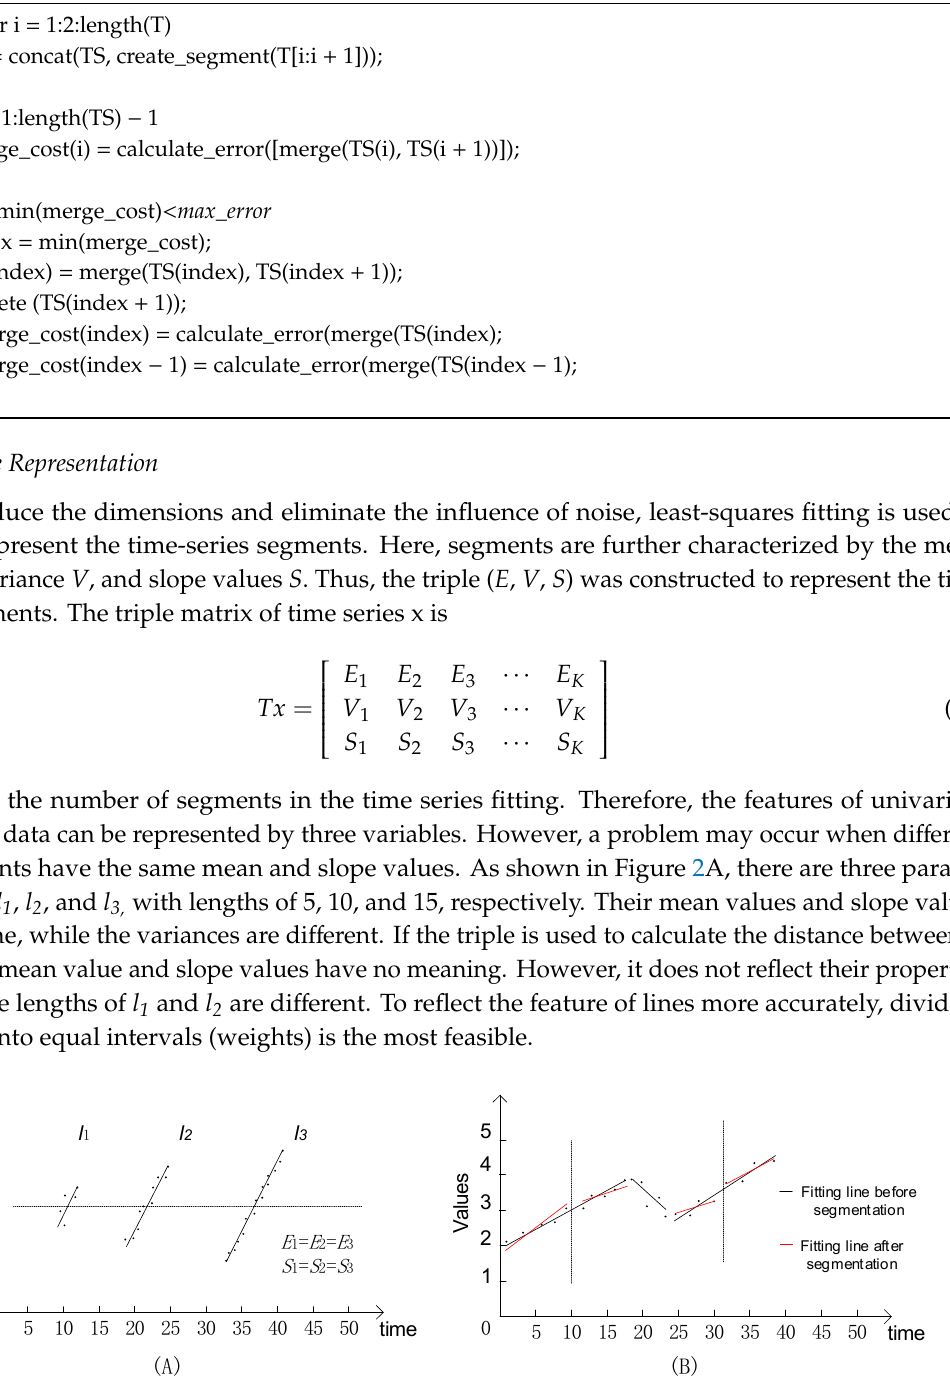
Figure 3. The fitting line of the data after segmenting with d = 5, max_error = 0.1. It cannot be guaranteed that each of the segments is the same after segmentation. For instance, the length of the third segment after segmentation is 4 in Figure 1B. However, the homogeneity of the segments can be guaranteed. In addition, the time series is represented as a matrix of triples after equal interval segmentation. 3.3. Metric Learning DTW is often used to calculate the univariable time series distance. In [28], DTW was extended to a multivariable time series, and the Euclidean distance was used for the local distance. The Euclidean distance considers each variable without considering the relationship between variables and is affected by noise and irregularity. In [19], DTW based on the Mahalanobis distance was used to calculate the multivariable distance for the first time. The Mahalanobis distance assigns different weights for different variables, and the relationships between variables are considered. 3.3.1. Calculate Multivariate Local Distance As described above, the features of the time series are represented as a matrix of triple ( E k , V k , S k ). In a triple matrix, each point is a vector. Therefore, the local distance between the two triples is the distance between two vectors. The basic structure is shown in Figure 4, where Tx and Ty are two